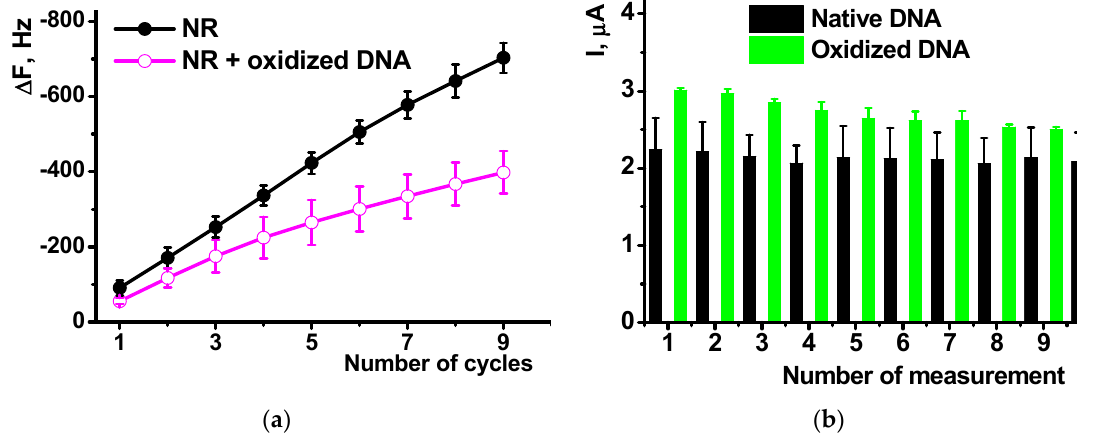
Figure 9. The influence of DNA oxidation on the efficiency of the NR polymerization monitored by EQCM ( a ) and on the poly-NR cathodic peak current ( b ) recorded by cyclic voltammetry on bare glassy carbon covered with poly-NR. DNA 0.2 mg/mL, measurements in 25 mM phosphate buffer + 0.1 NaNO 3 , pH 6.0. Results are mean ± SD from six replications.